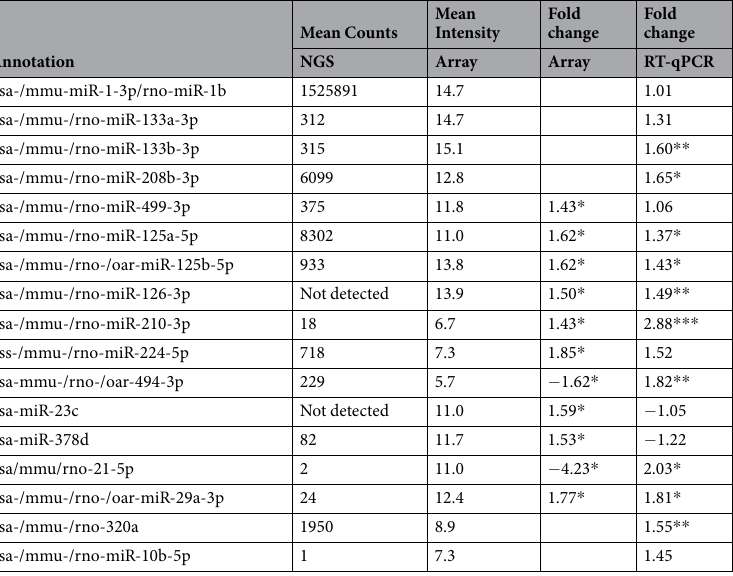
Table 3. Summary of HF-regulated microRNAs detected by next generation deep sequencing (NGS), differential expression by miRNA array and validation by stem-loop qPCR. * P < 0.05, ** P < 0.01, *** P < 0.001 versus normal